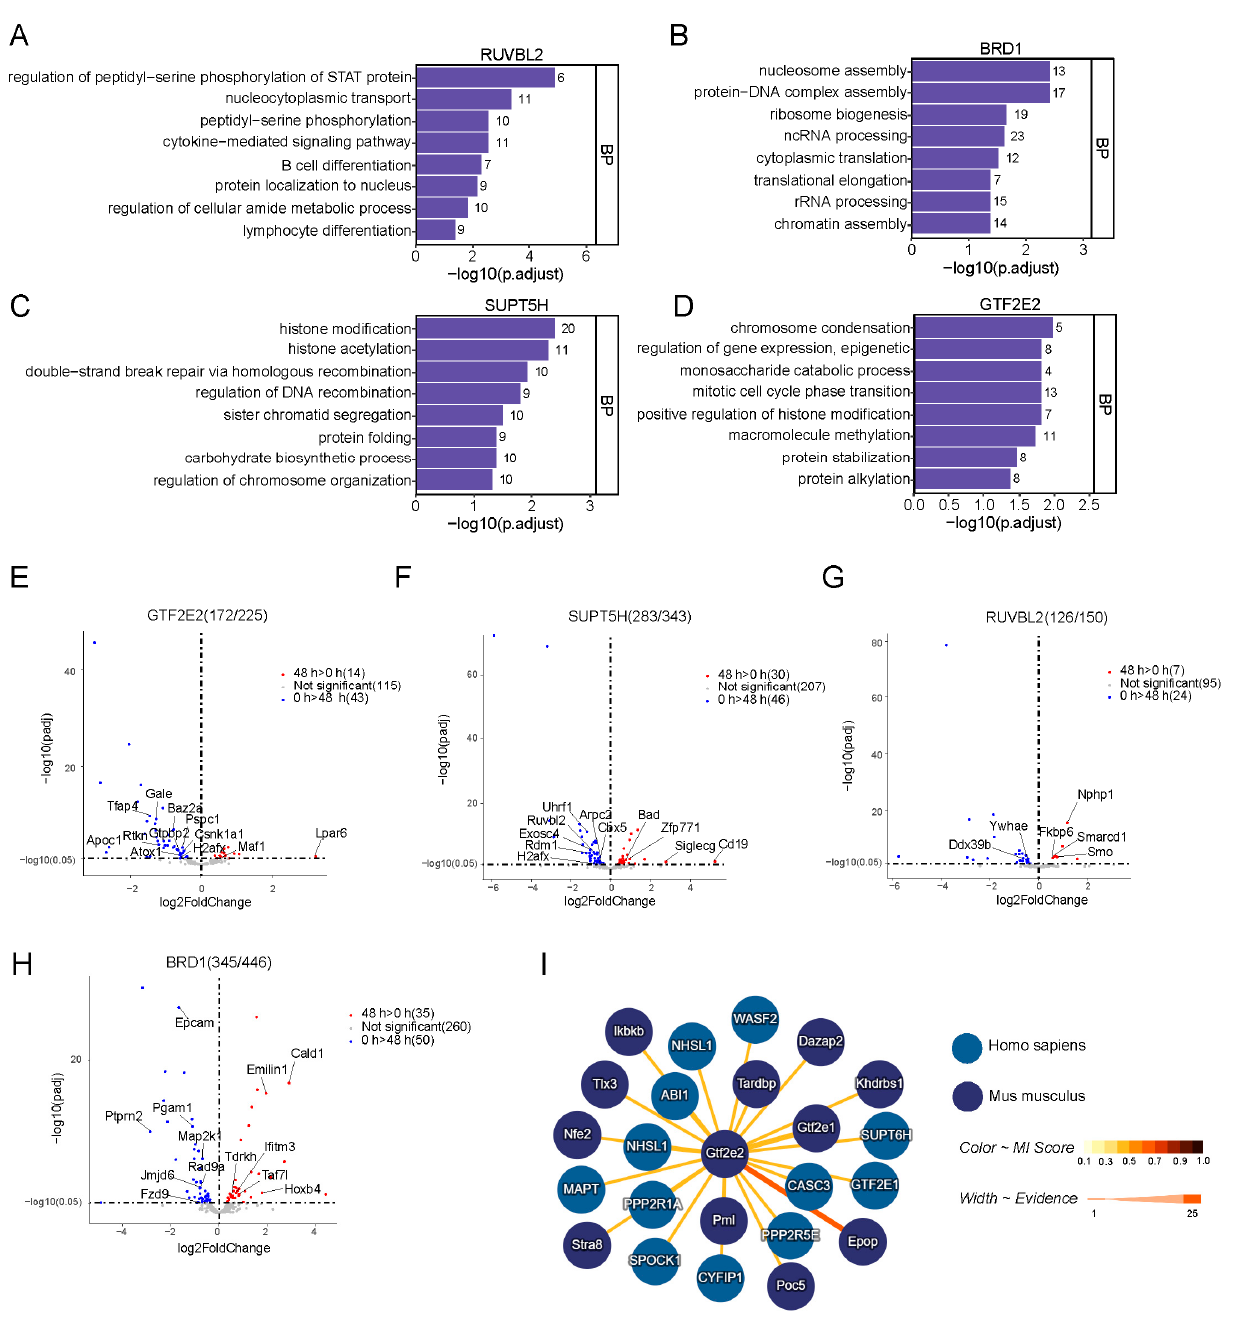
Figure 4. Gene function analysis of target genes regulated by four transcription factors. ( A – D ) GO enrichment for target genes regulated by four transcription factors through CISTROME database. ( E – H ) The expression level of target genes identified in our RNA-seq data. ( I ) Protein interaction prediction through IntAct Molecular Interaction database.